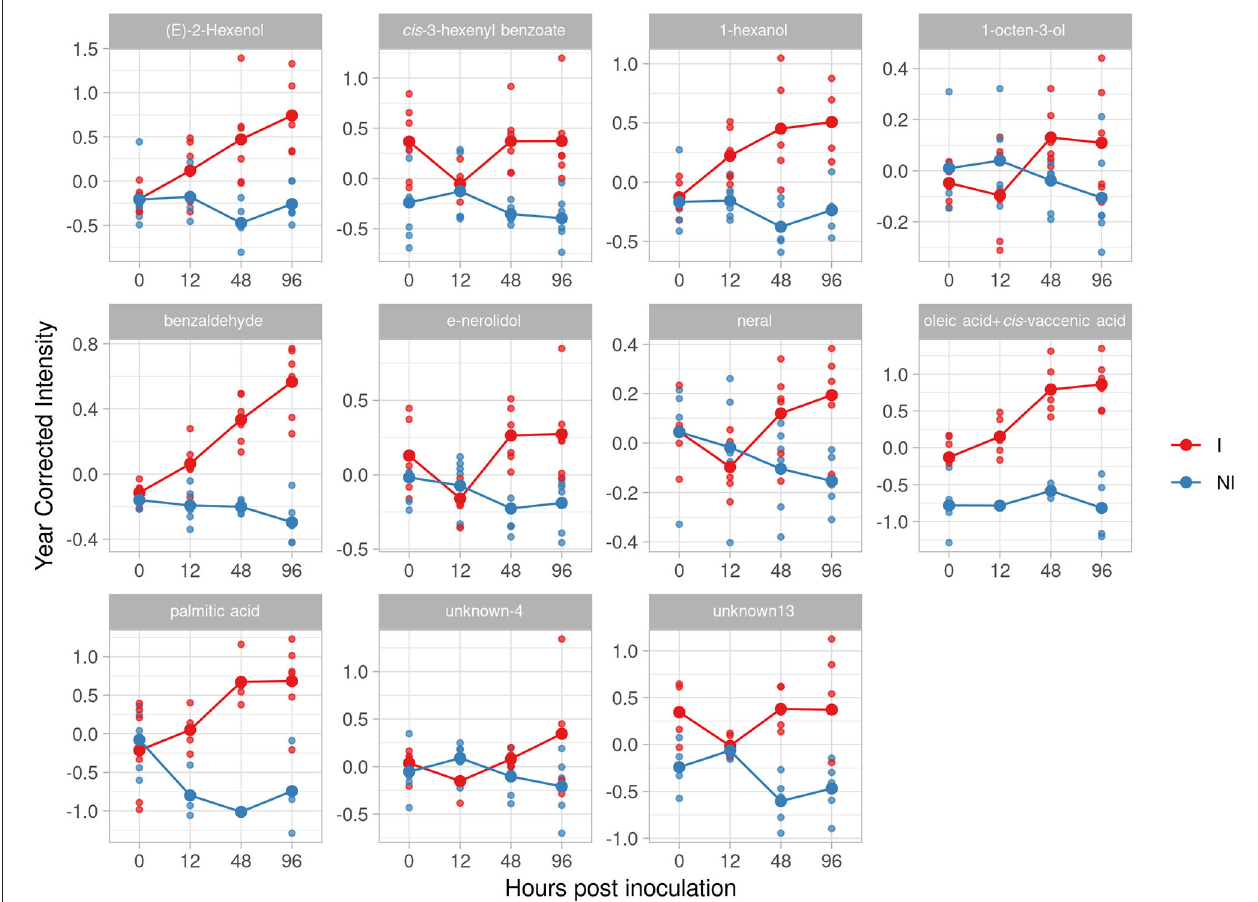
FIGURE 9 | Graphs for specific putative biomarkers of resistance to Plasmopara viticola in inoculated (Red) and not inoculated (Blue) F12P60 genotype. Values of the 2 years are reported subtracting the year’s effect.